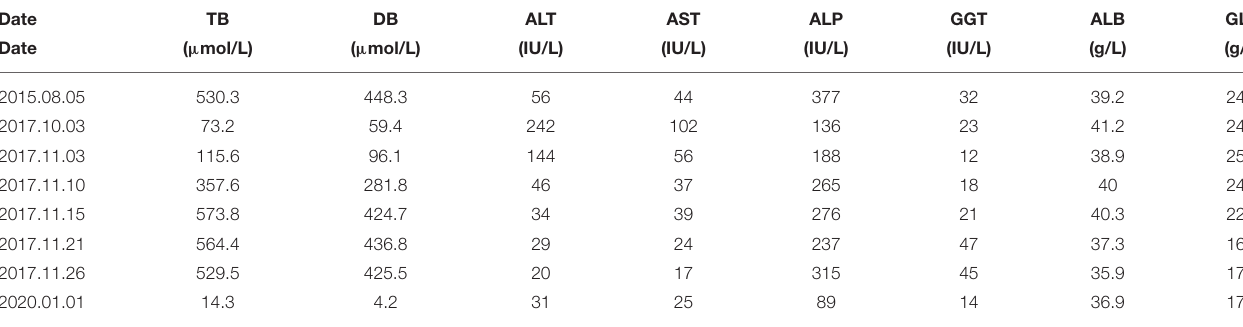
TABLE 1 | The dynamic changes of liver function.